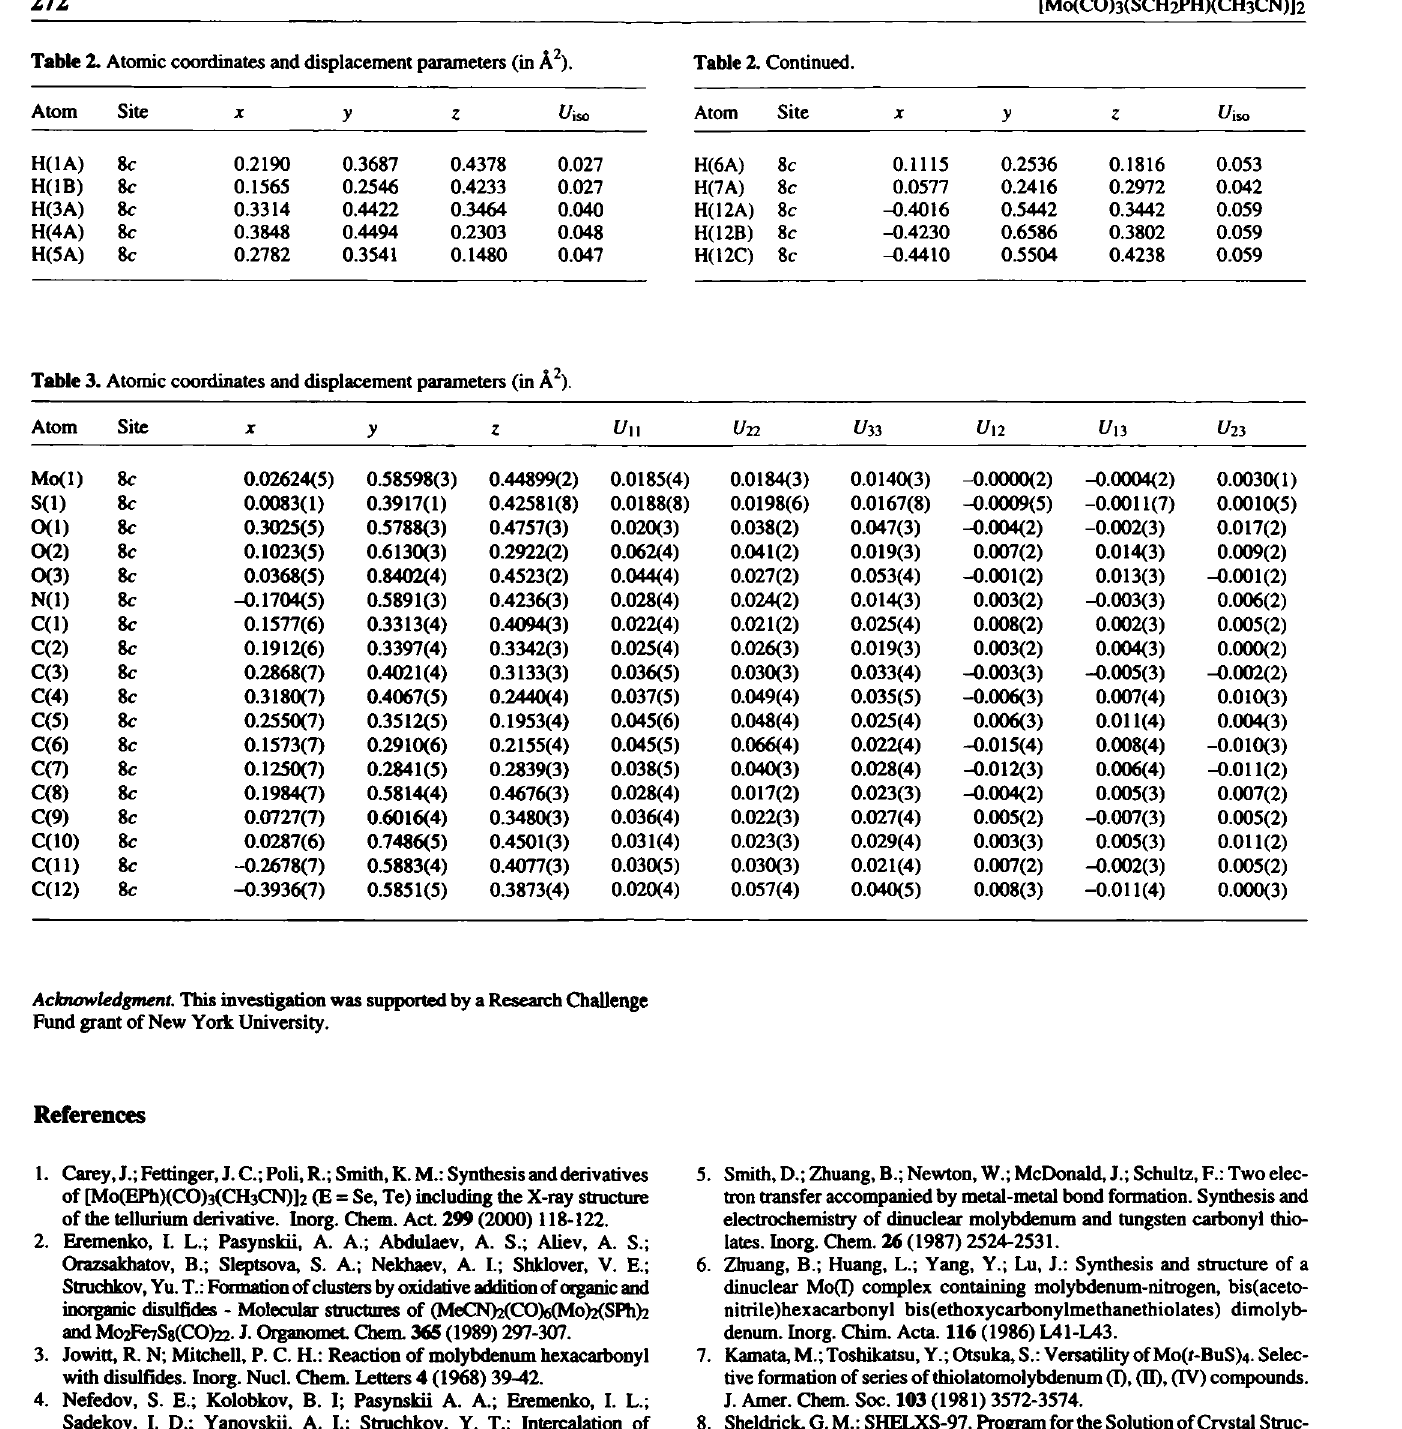
Table 2. Atomic coordinates and displacement parameters (in Â 2 ).